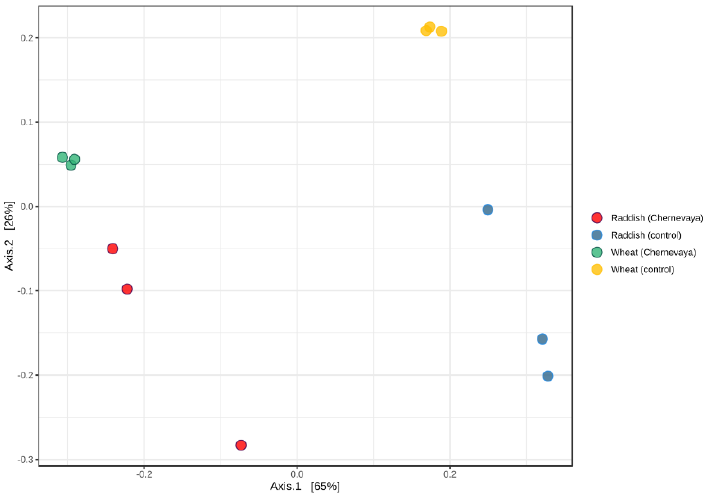
Figure 3. Analysis of beta diversity structure of rhizosphere microbiome samples visualized by principal component analysis (PCA) using Bray – Curtis dissimilarity index.